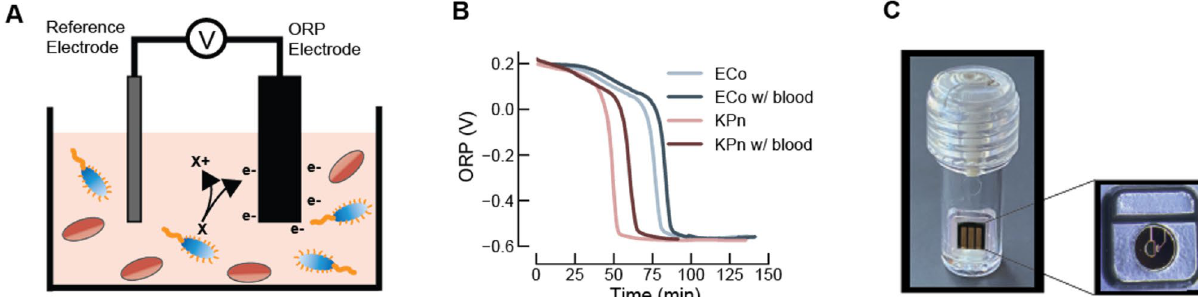
Figure 2. Electrical sensor principle. ( A ) The electrical sensor is composed of a sensing oxidation–reduction- potential (ORP) electrode (black) and a reference electrode (grey). The output of the sensor is the voltage difference (V) between the reference electrode and the ORP electrode. During bacterial metabolism, very reduced molecules are produced (X > X +), which readily give up electrons (e-) to the ORP sensitive sensor material. While the reference electrode maintains a fixed voltage, the bacteria change the solution ORP as electrons accumulate on the ORP sensitive sensor surface. Consequently, the overall voltage becomes more negative. ( B ) Representative ORP growth curves for two Gram-negative organisms, E. coli (ECo) and K. pneumoniae (KPn), measured in both the absence and presence of blood (PBC diluted 1:30 in growth media). ( C ) Photo of the eTube consumable with the packaged sensor integrated into the wall of the tube and contact pads facing the outside for interfacing with the read-out electronics. The inner-facing side of the sensor is shown (enlarged) to the right with a molded open cavity (black circle) exposing the ORP sensing electrode to the liquid